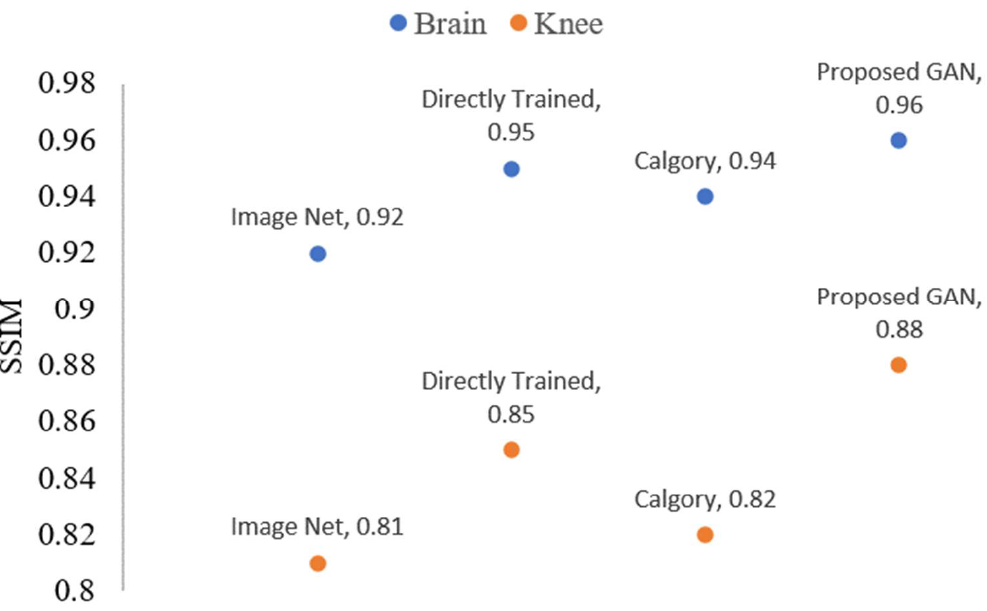
Figure 16. The blue dots represent brain data SSIM values, while orange dots represent knee data SSIM values of the reconstructed images when AF = 2 following TL.